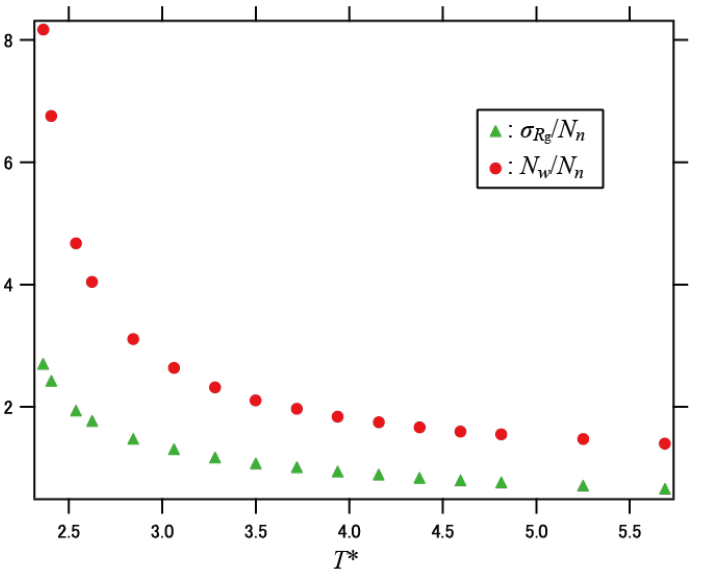
Figure 4. Relative standard deviation σ R g /N n for the radius of gyration and the dispersion index N w /N n plotted against temperature.